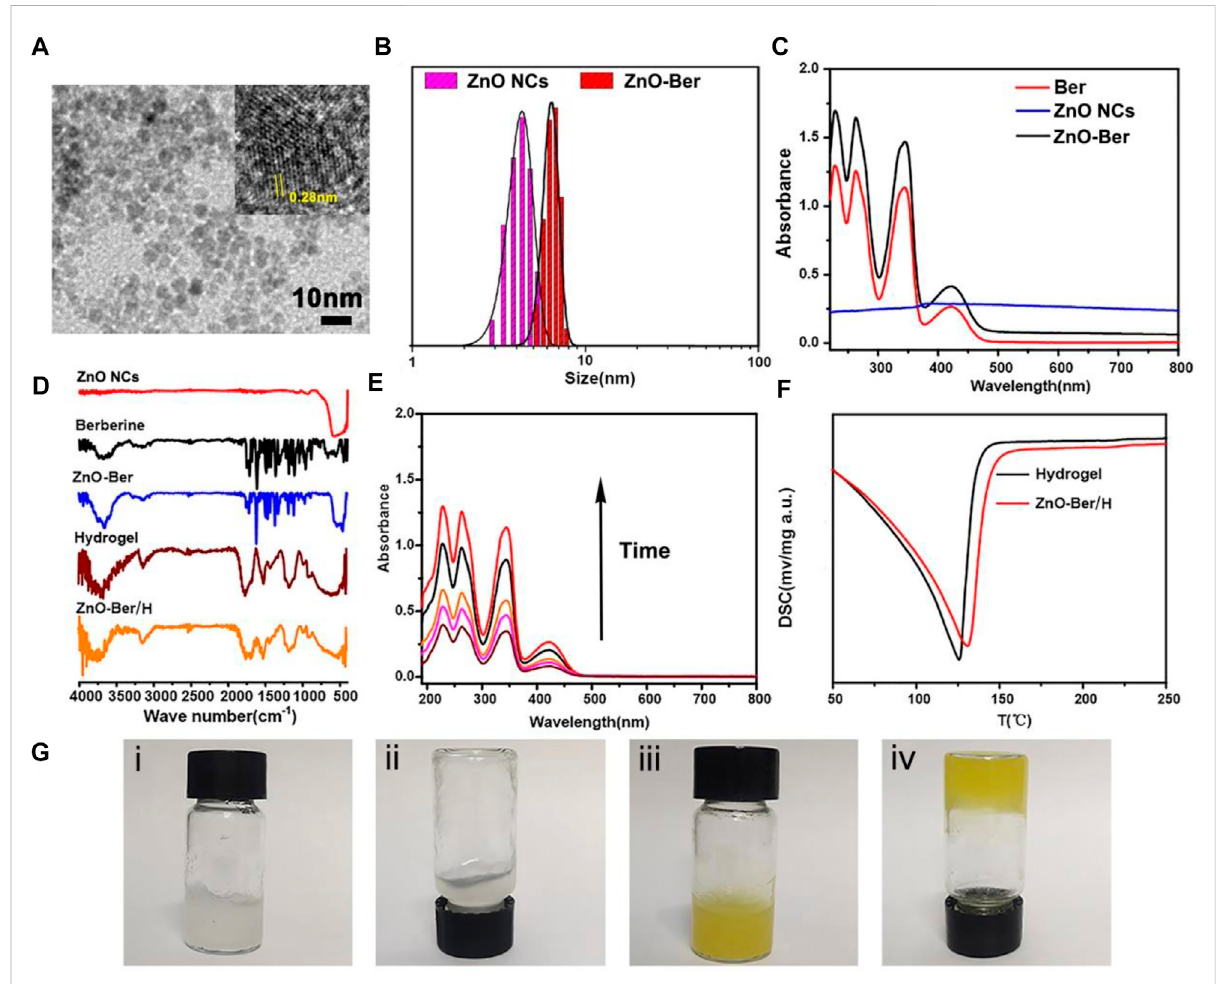
FIGURE 1 (A) TEM images of ZnO NCs, the insert was the labeled distance of 2.8 Å corresponded to the {10 1 0} lattice spacing. (B) The size and size distributionsofZnONCsandZnO-BerweredeterminedbyDLS. (C – D) UV – visdataandFTIRspectradataofZnONCs,BerberineandZnO-Ber/H. (E) Released of berberine from ZnO-Ber in different time. (F) DSC results of the Hydrogel and ZnO-Ber/H. (G) Digital photos of Hydrogel and ZnO-Ber/ H. Scale bar, 10